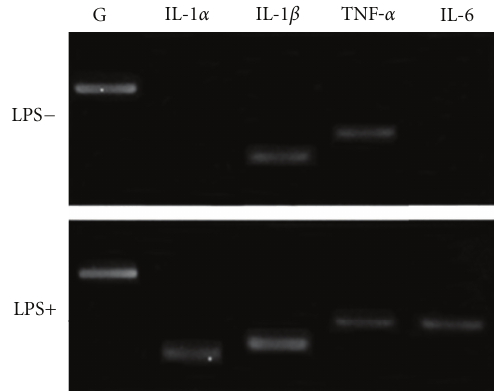
Figure 3: Expression of pro-inflammatory cytokine genes in human macrophages. IL-1 α , IL-1 β , TNF- α , IL-6, and GAPDH gene expression in hMO cultures with and without LPS stimulation for 24 hours. 1 μ g/mL of LPS was used in the experiment. mRNA was isolated at 24 hours. RT-PCR was carried out at 30 cycles for all